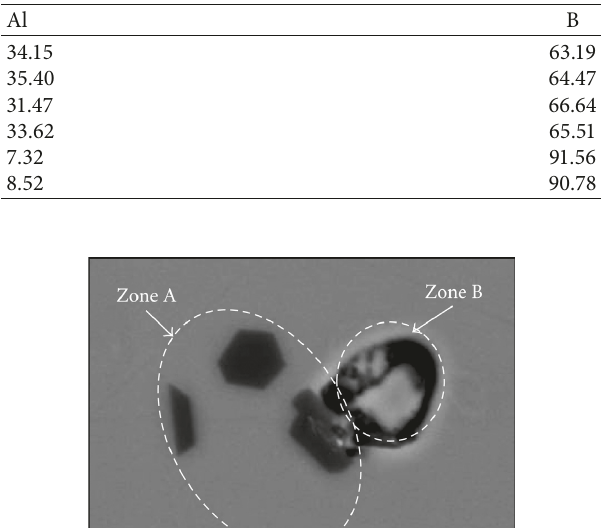
Table 3: WDS analysis (at.%) of AlB Figure 13(a).